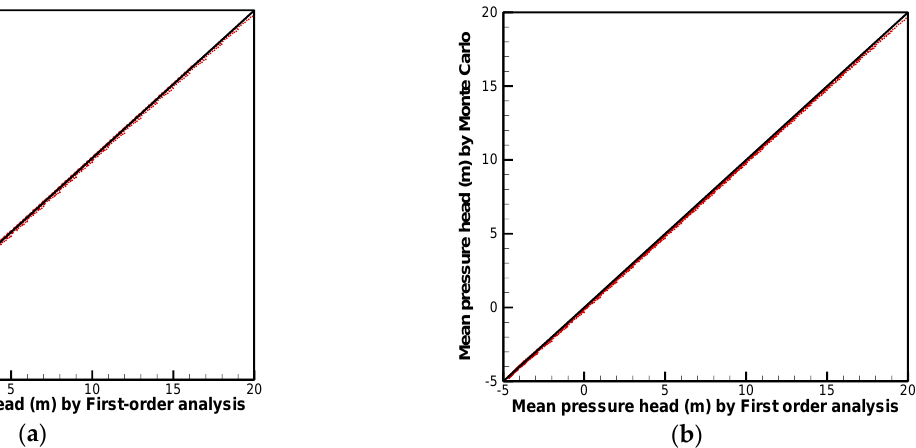
2 =0.7 and ( b ) = 0.7 and 2 =0.7 and ( b ) 𝑠 ln K s 𝑠